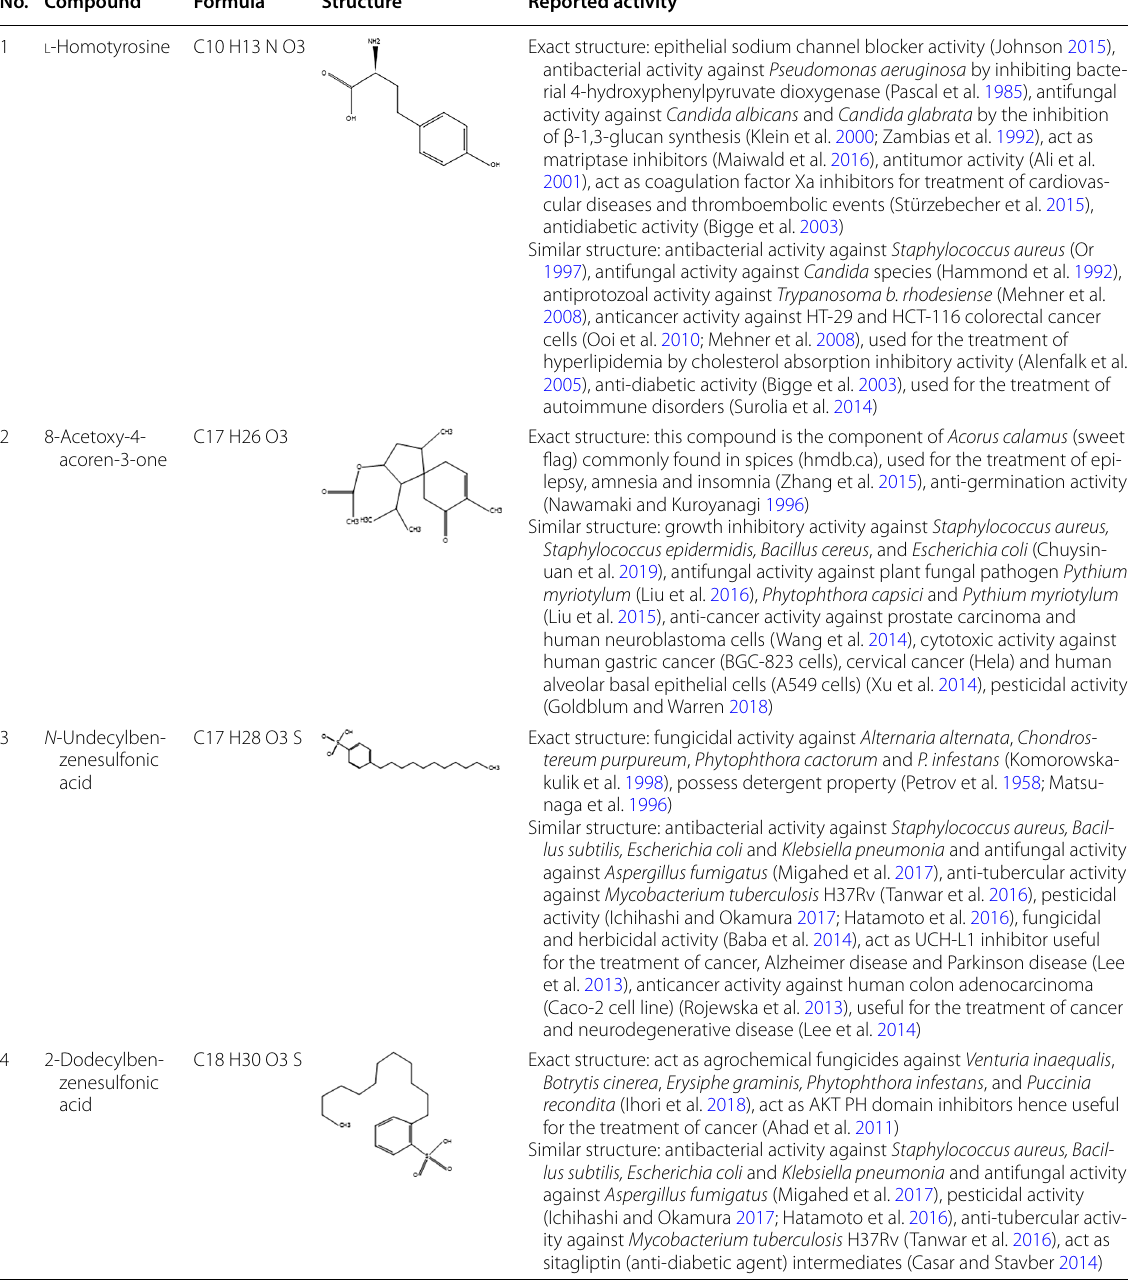
Table 2 Compounds identified from the red centipede haemolymph No.